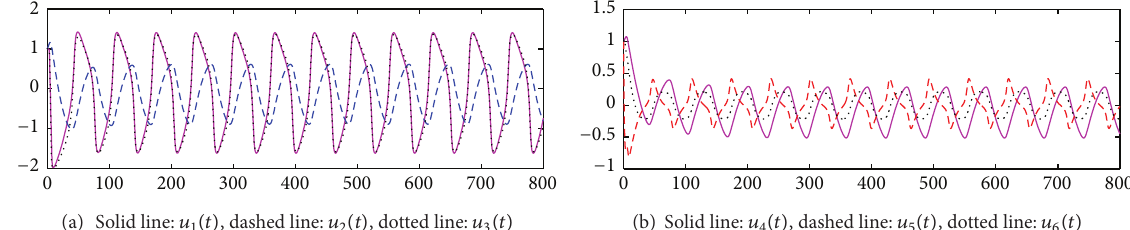
(b) Solid line: 𝑢 4 (𝑡) , dashed line: 𝑢 5 (𝑡) , dotted line: 𝑢 6 (𝑡) Figure 3: Periodic oscillatory behavior, activation function: tanh (𝑢) , and delays: (1, 2, 3).